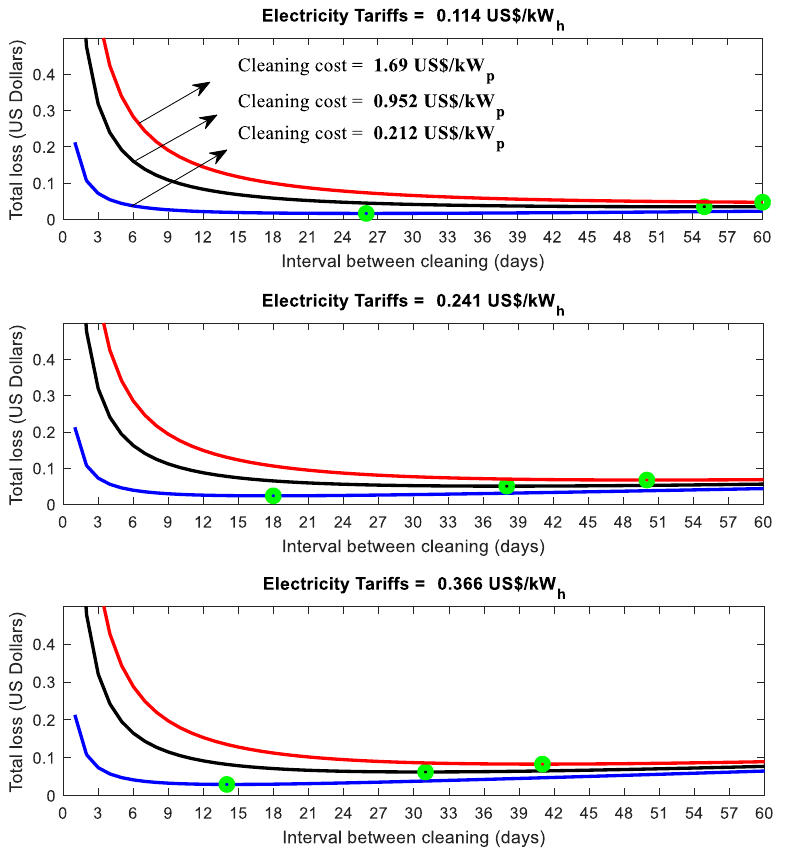
Figure 11. Total average daily losses together with the optimal cleaning frequency (circles) obtained for the nine different combinations of cleaning costs and dust accumulation.